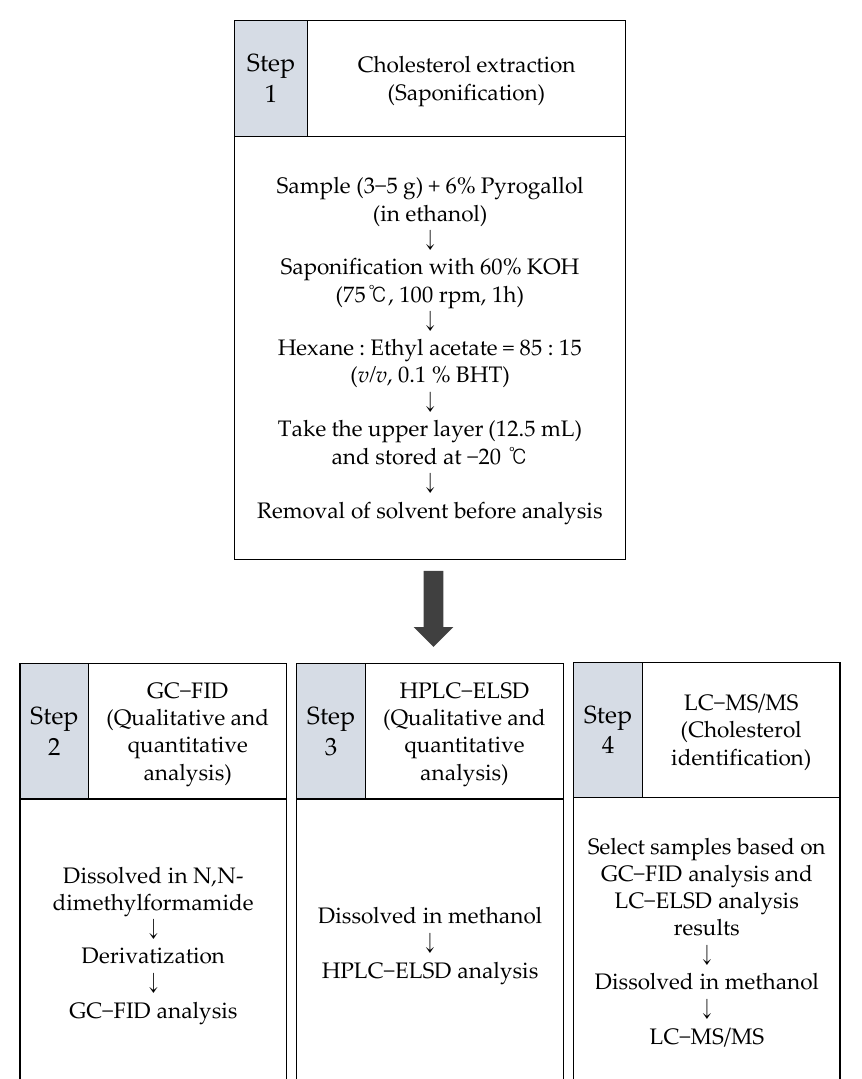
Figure 1. Scheme of the experimental design.